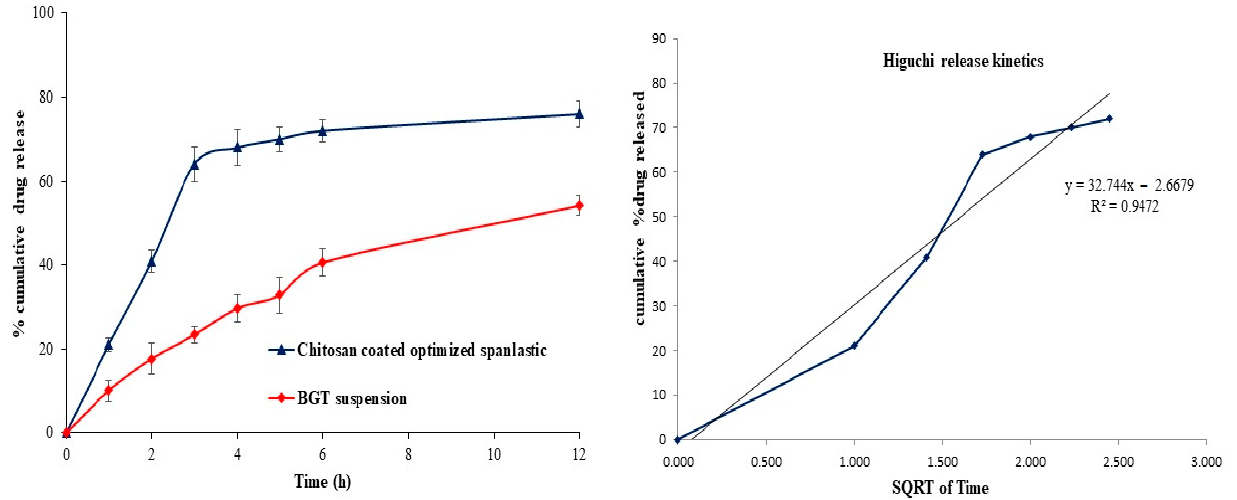
Table 3. Drug release kinetic models for optimized chitosan-coated NSPs.